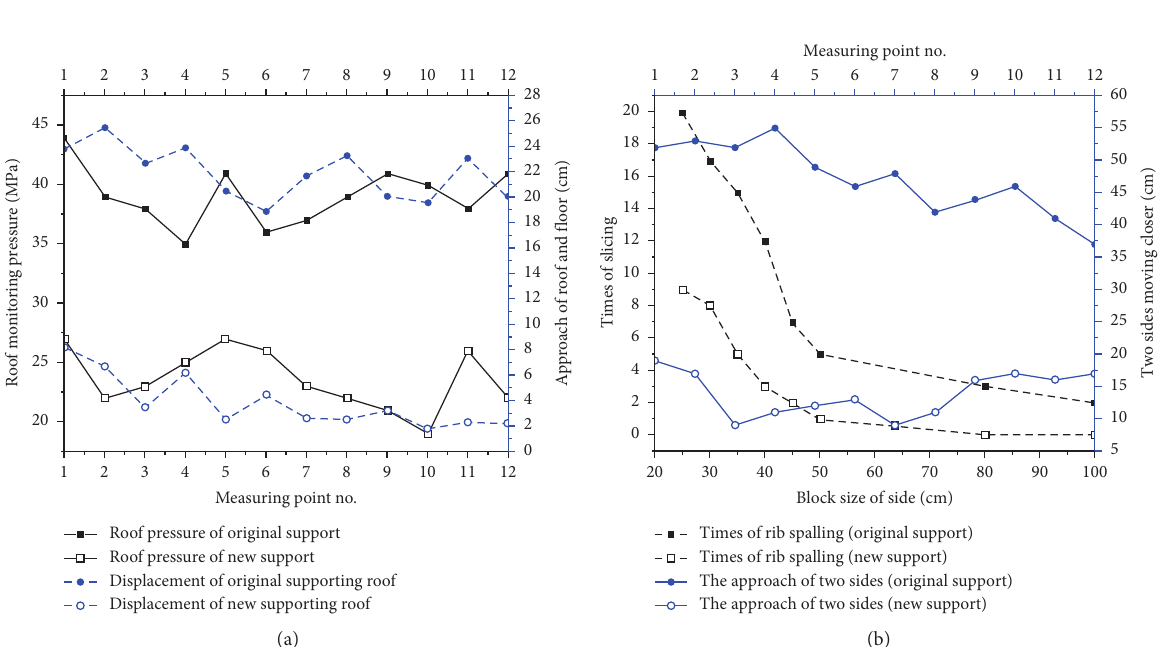
Figure 14: Biaxial curve of roadway monitoring parameters. (a) Stress and displacement of roadway roof. (b) Side slicing times and the distance between the two